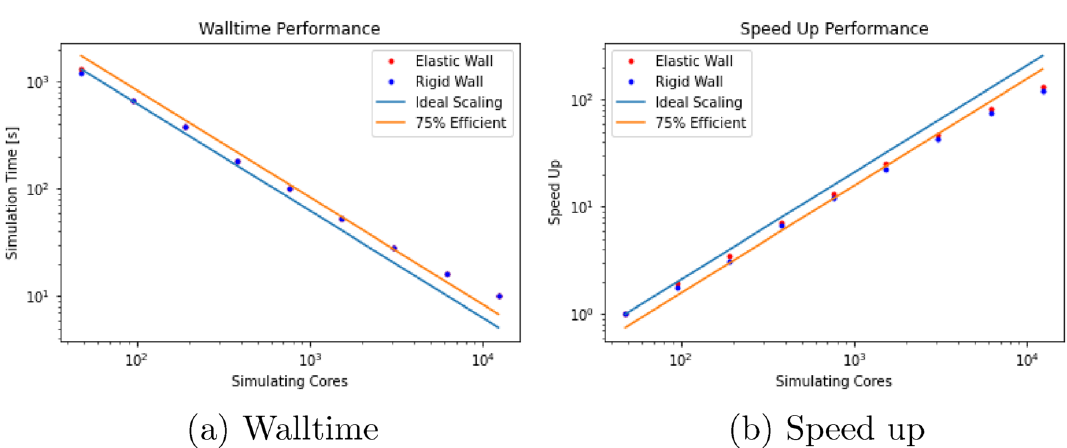
Figure 4. Relative error along the central axis of the test cylinder comparing ( a )–( c ) the current elastic wall method and ( d )–( f ) the rigid wall method to the elastic wall analytical solution for the case of k p 0.0 m and the outlet at L 0.04 m. The flow inlet was at L = =